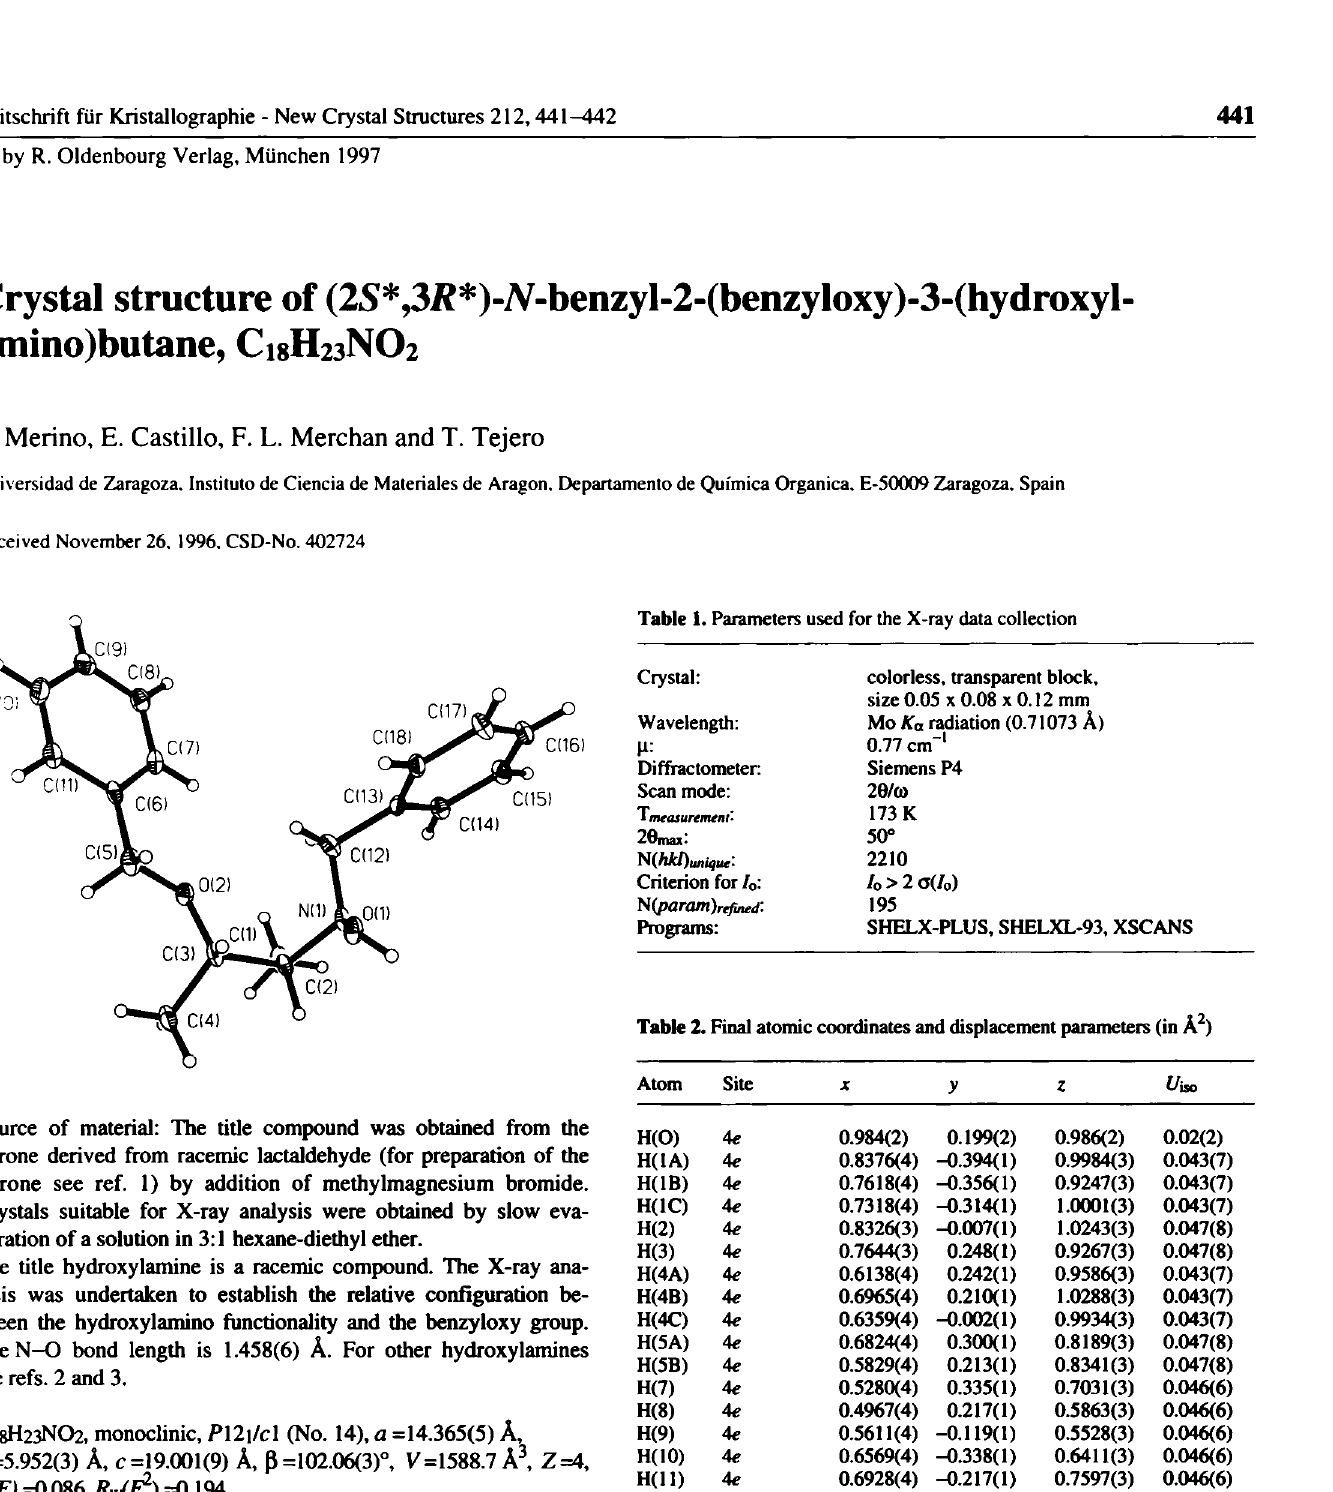
Table 3. Final atomic coordinates and displacement parameters (in Â 2 )